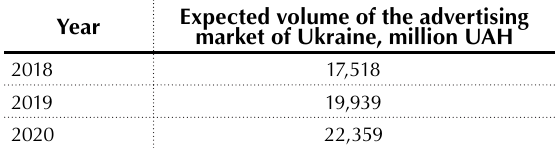
Table 3. The expected dynamics of change of volume of the advertizing market of Ukraine during the period 2018−2020